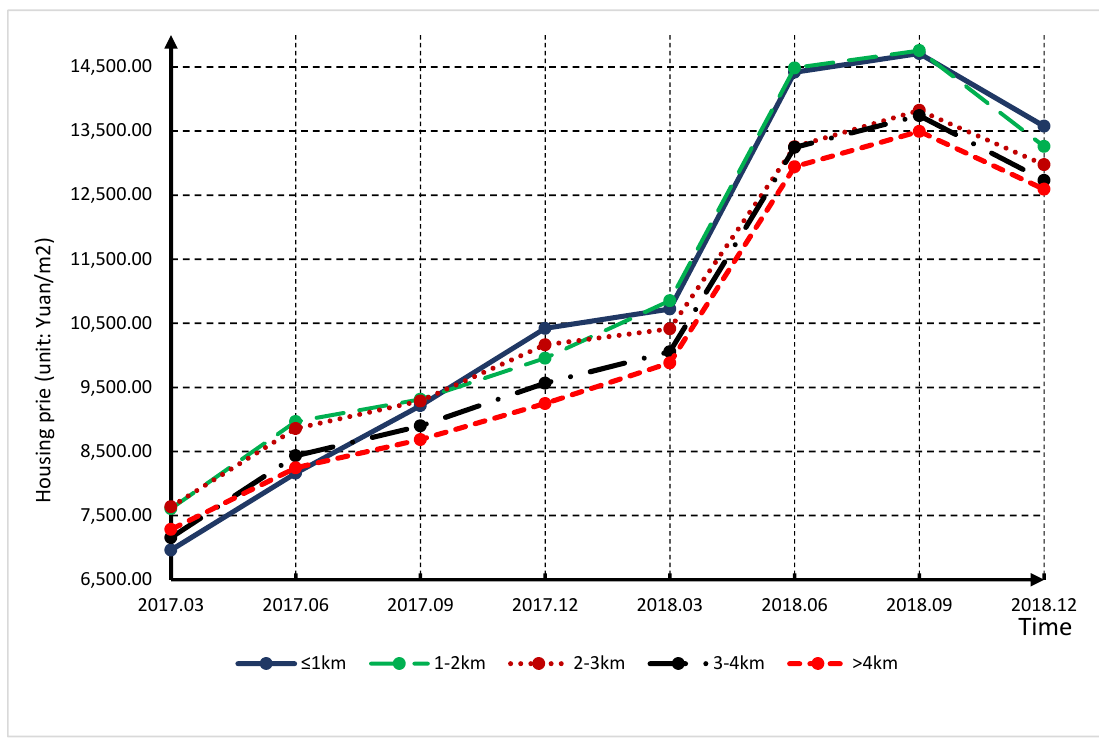
Figure 4. Average housing prices of different radiation areas from March 2017 to December